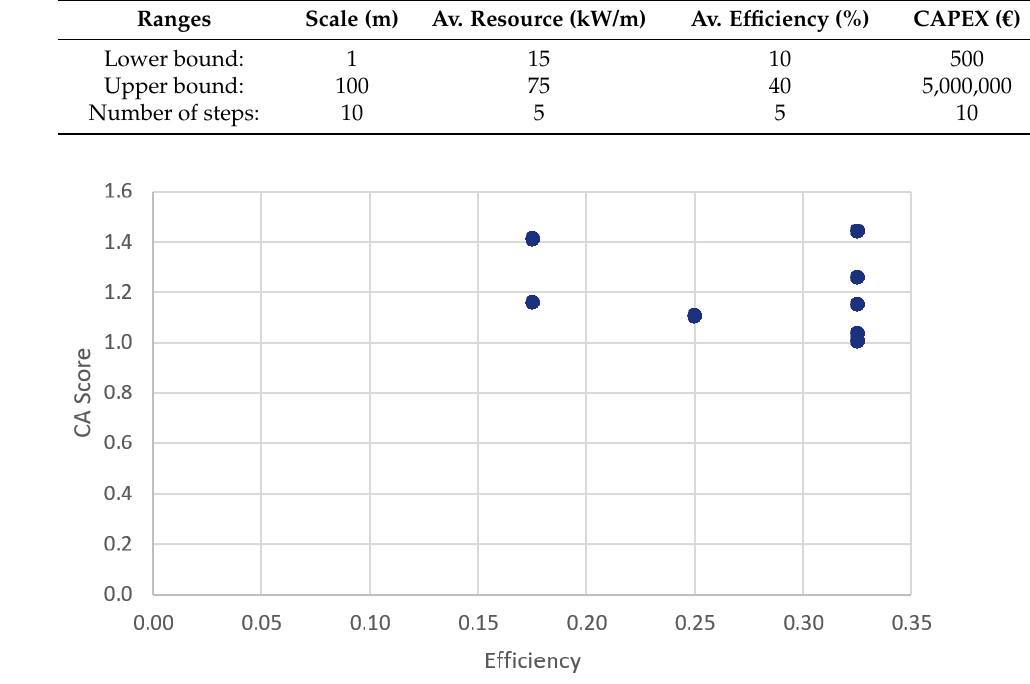
Figure 13. Results of the zoomed in efficiency (10–40%) scenario for Heave showing the range of commercially attractive, possible and achievable efficiencies to be between 17–32%.